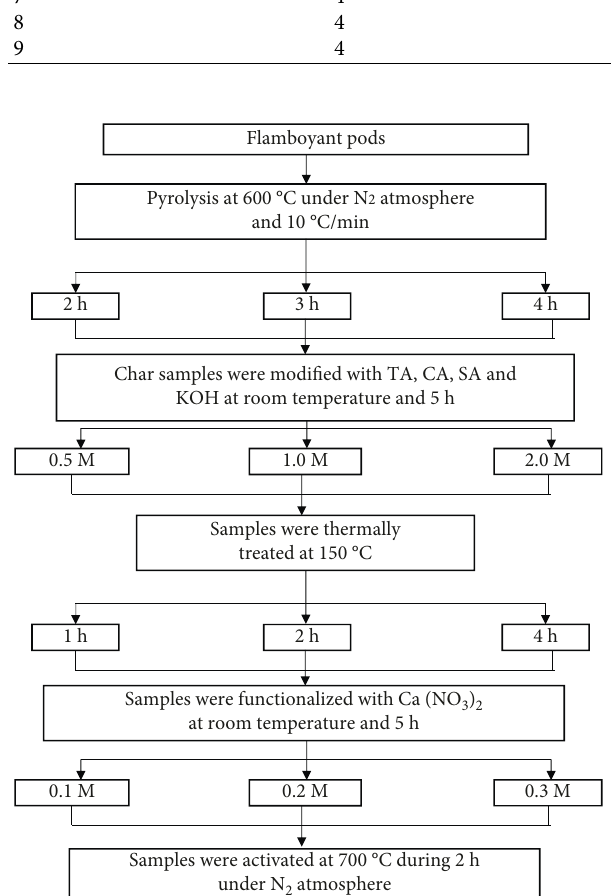
Figure 1: Main steps involved in the functionalization and acti- vation of acidic and alkaline heterogeneous catalysts for obtaining biodiesel via vegetable oil